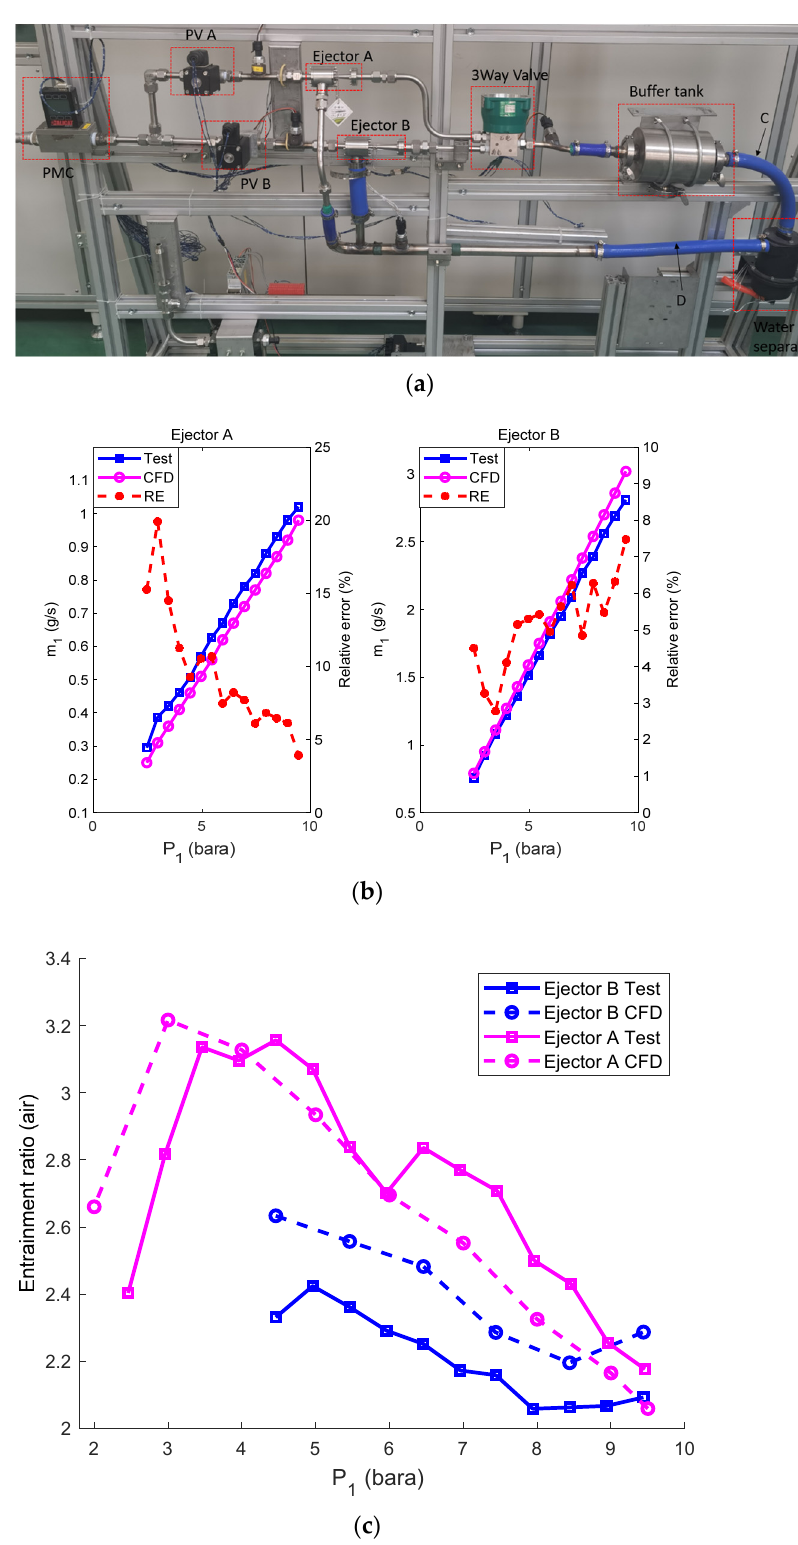
Figure 7. Comparisons of test and CFD simulation results. ( a ) Photograph of the test bench; ( b , c ) primary pressure P 1 , mass flow rate m 1 , relative error (RE), and entrainment ratio for Ejector A and Ejector B, respectively.